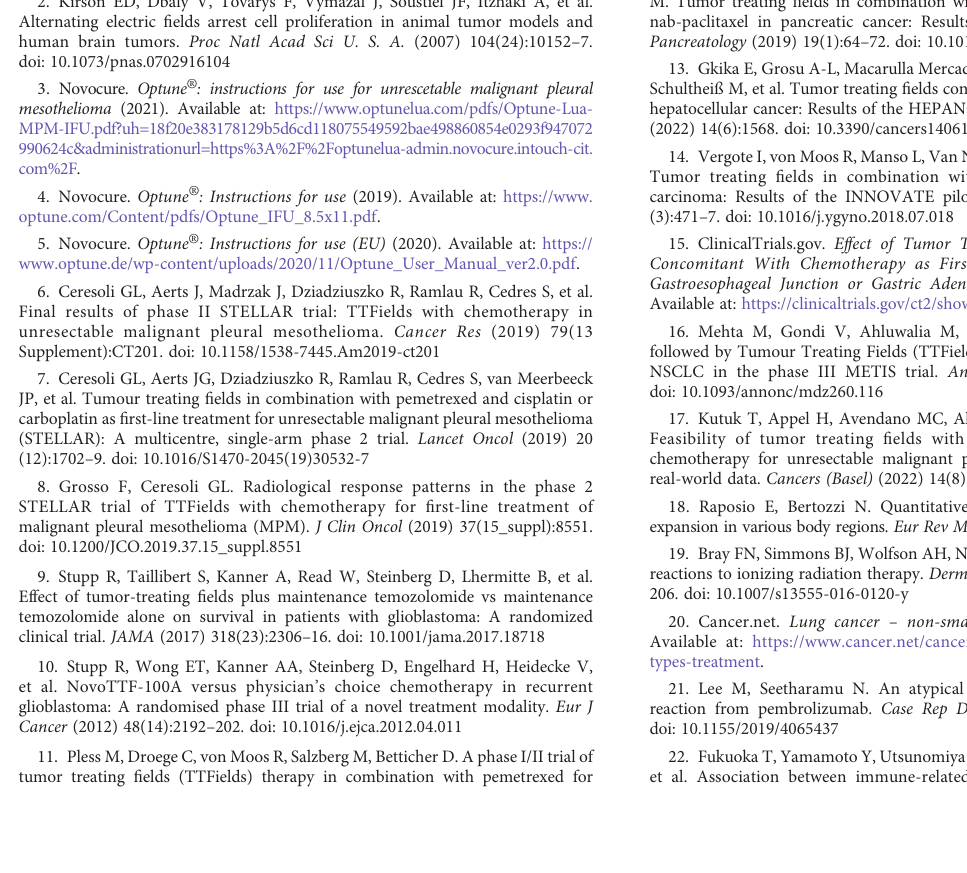
SUPPLEMENTARY FIGURE 1 Infographic on the prevention and management of Tumor Treating Fields (TTFields) therapy-related skin adverse events. SUPPLEMENTARY FIGURE 2 Interactive infographic for management and prevention of Tumor Treating Fields (TTFields) therapy-related skin adverse